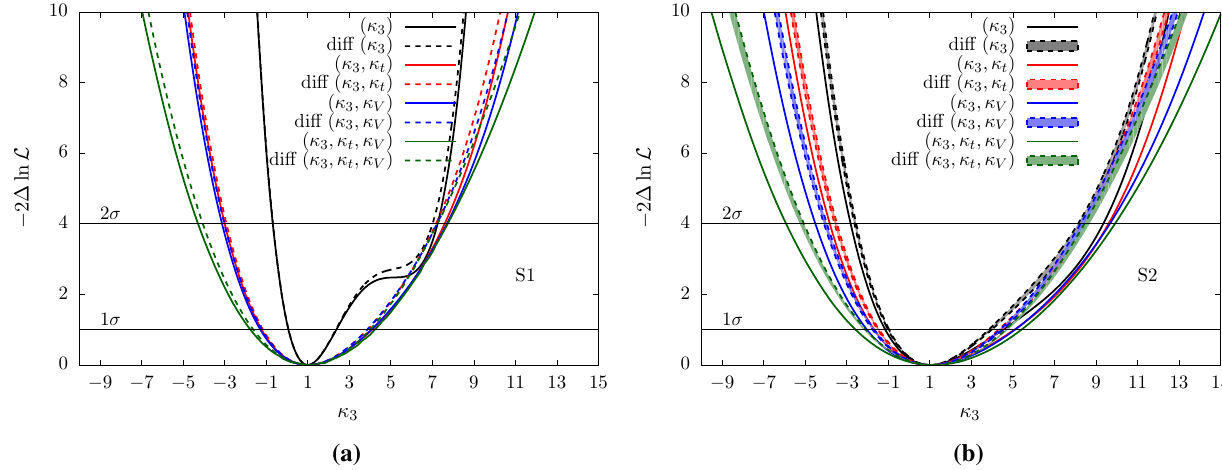
Fig. 13 1 σ and 2 σ bounds on κ 3 including all production processes, based on future projections for ATLAS-HL at 14 TeV. Left: only statistical uncertainty (S1). Right: experimental systematic uncertainty and theoretical uncertainty included (S2)